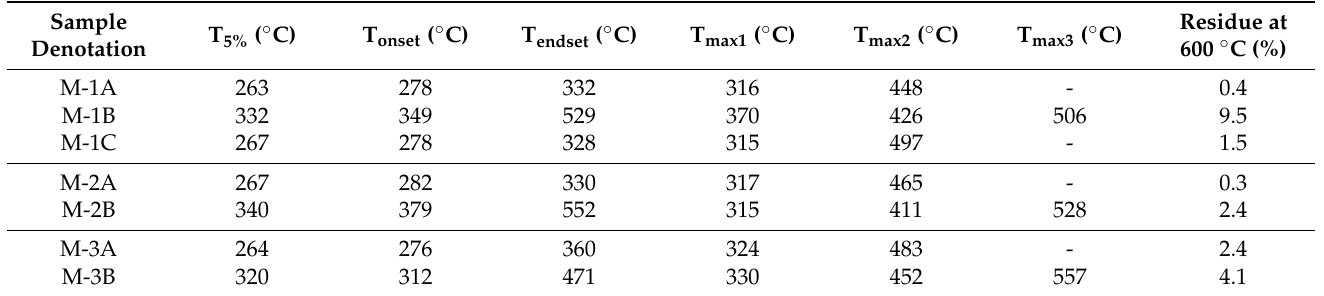
Table 1. Mass losses and decomposition temperatures of all